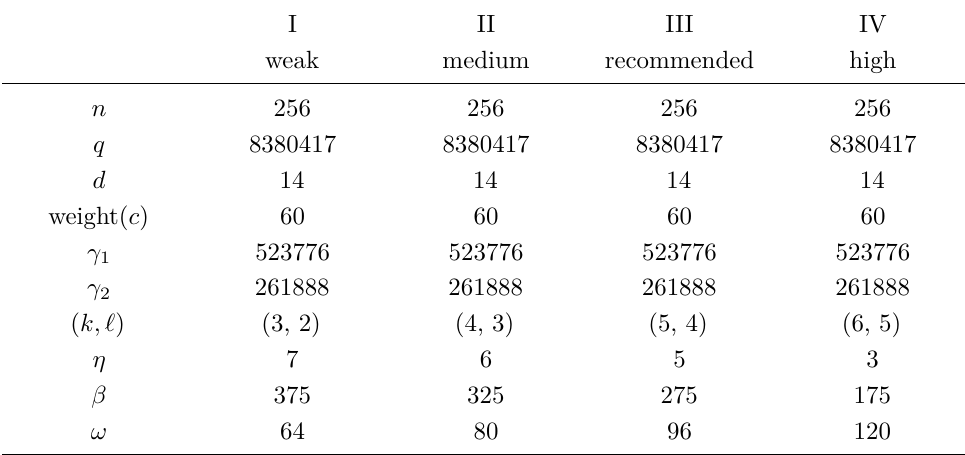
Table 7: Dilithium Parameter